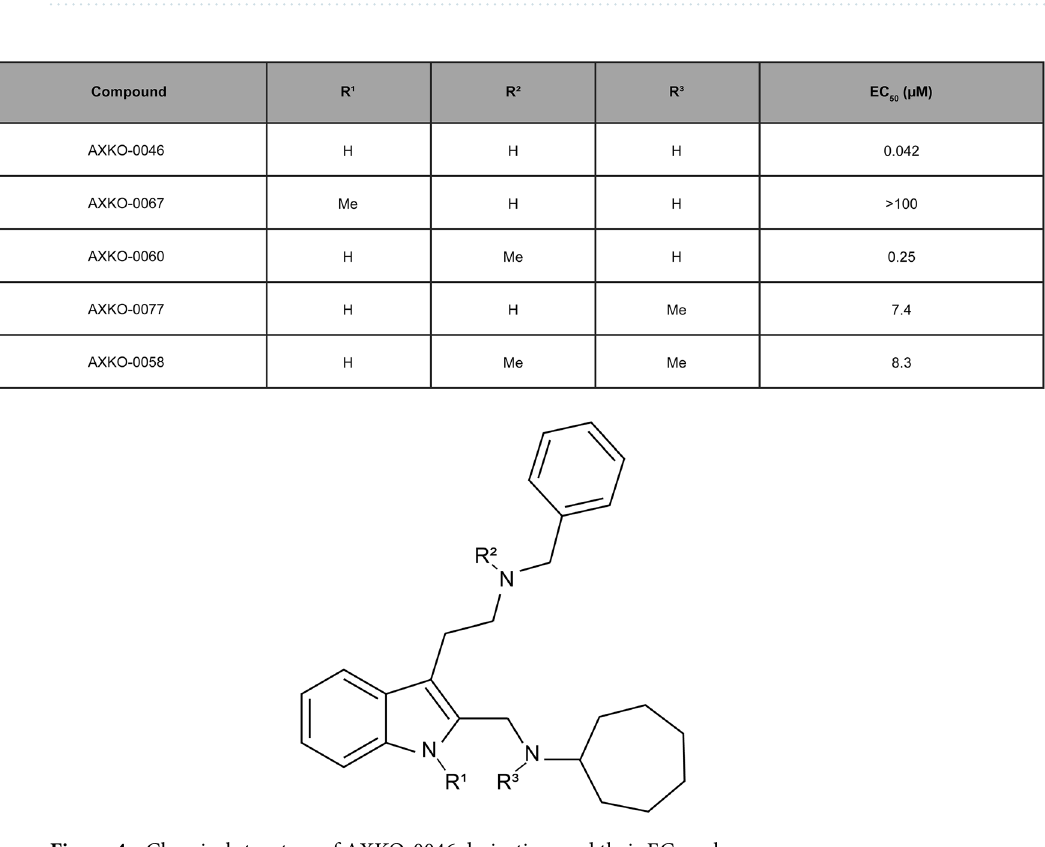
Figure 4. Chemical structure of AXKO-0046 derivatives and their EC 50